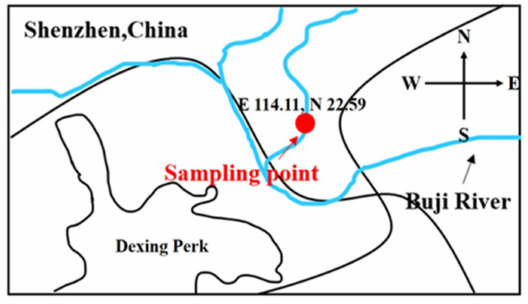
Figure 1. Coordinate system for the sampling.